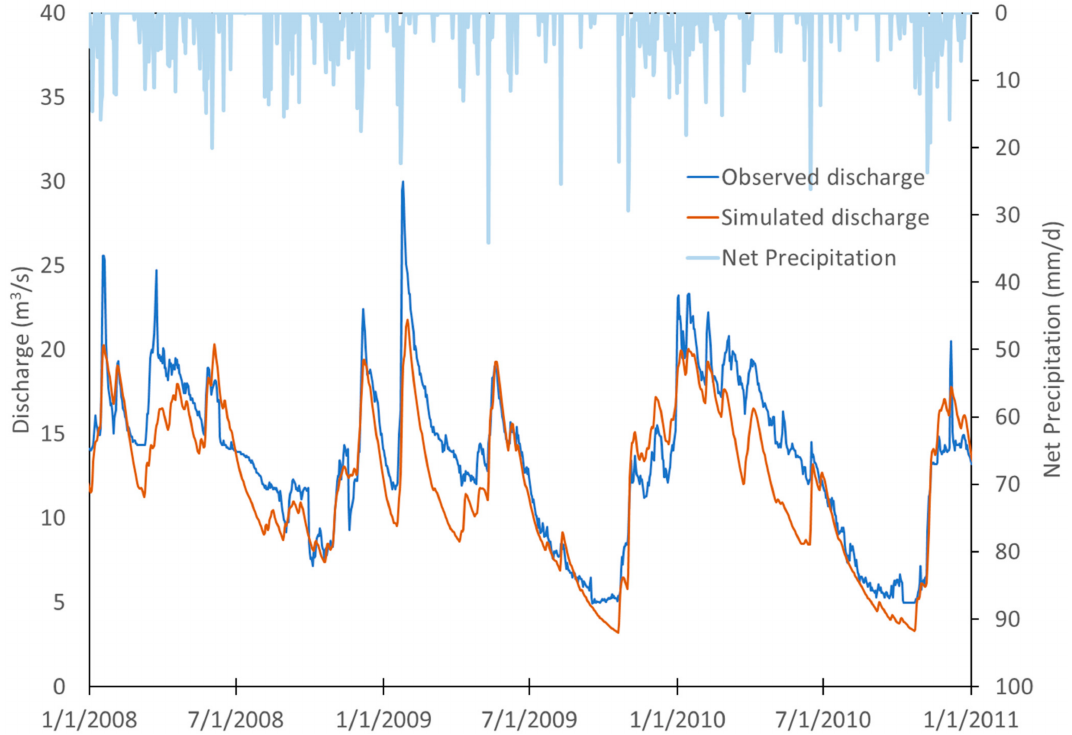
Figure 3. Comparison between observed, simulated and natural discharge at the outlet of the Touvre karst aquifer over the 2008–2010 period